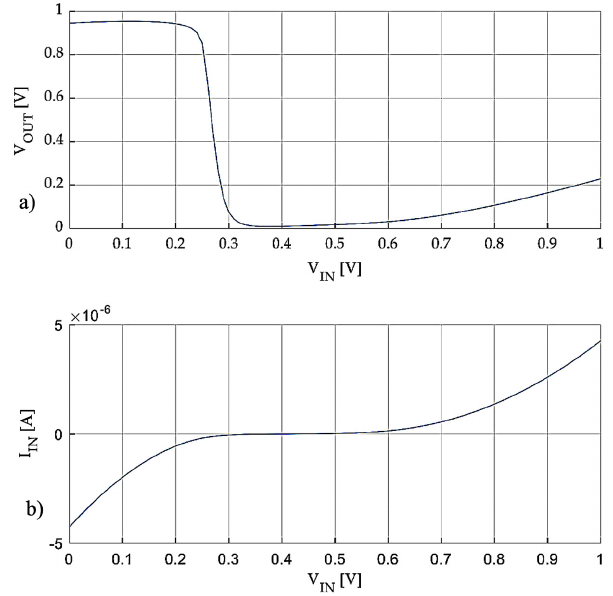
Figure 12. The characteristics of the best inverter obtained on the third prototype wafer: ( a ) transfer characteristics of the inverter, ( b ) input current—negative current flows from the input to the source of the input signal (e.g., another gate), and positive current flows to the input from the source of the input signal (e.g., another gate) [27].